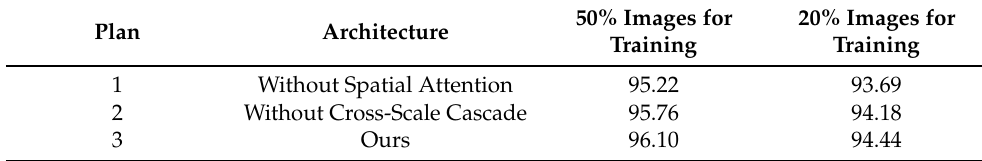
Table 6. Ablation study on the AID data set with the training ratios of 50% and